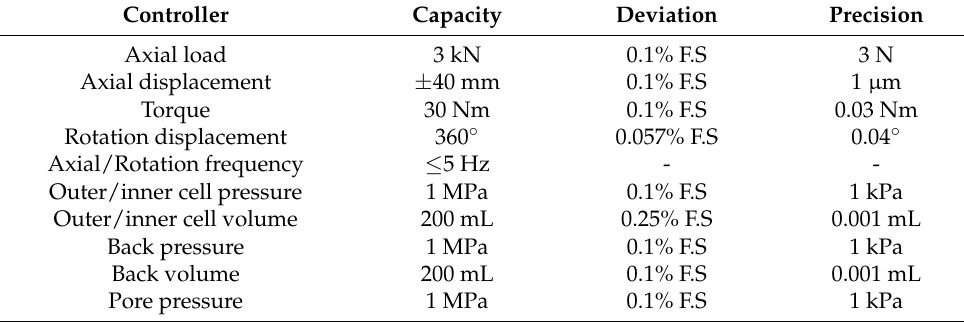
Figure 2. Hollow cylinder apparatus and illustrative stress state in a hollow cylindrical specimen subjected to axial load W , torque M T , inner pressure p i , and outer pressure p o : ( a ) applied loads, ( b ) stress components, ( c ) principal stress components, and ( d ) major, intermediate, minor principal stress. Table 1. Performance indexes of the apparatus used in this study.